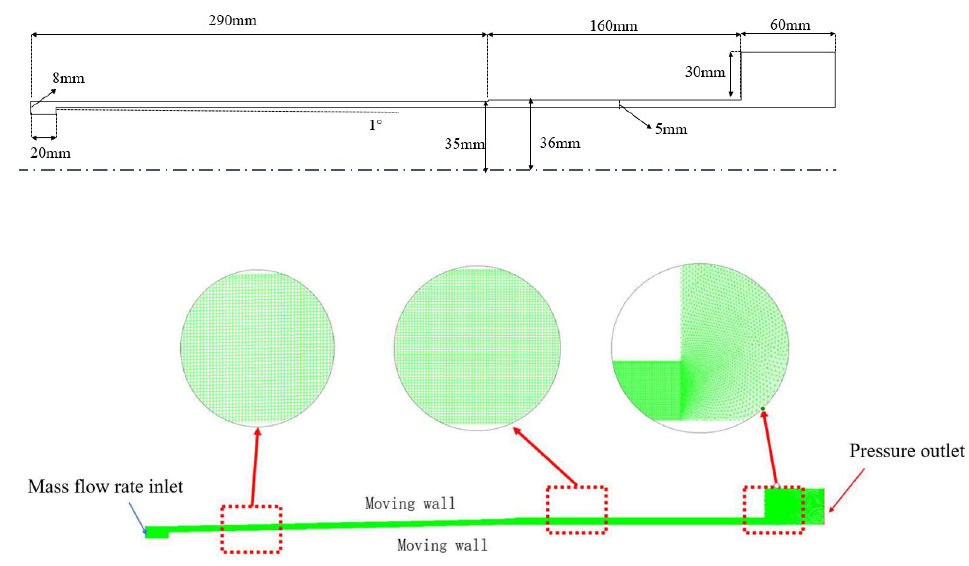
Figure 3. The geometry and mesh structure of the two-dimensional computational domain. The distribution of the water film gained in the 2D model is shown in Figure 4. The vapor region is represented by red color while the water region is represented by the blue color, and can provide the thickness of liquid film in 3-D simulation. As expected, the computational domain covers all the liquid film and a large aera of vapor near the